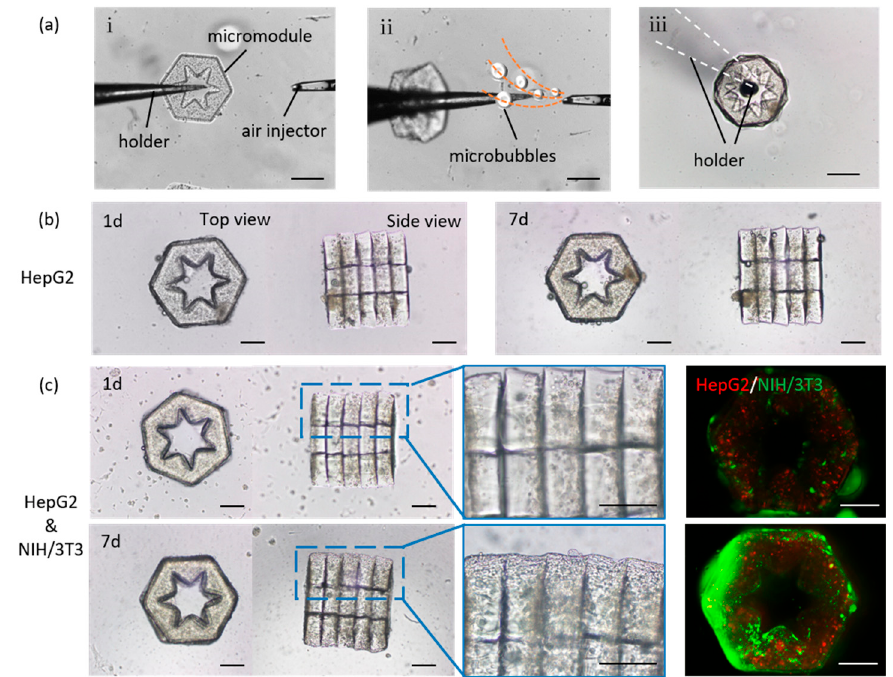
Figure 3. ( a ) 3D assembly process of lobule-like microtissues relying on local fluid-based micromanipulation, scale bars: 400 μ m; ( b ) Long-term culture of 3D lobule-like microtissues encapsulating HepG2 cells, scale bars: 200 μ m; ( c ) Long-term co-culture of 3D lobule-like microtissues encapsulating HepG2 cells and NIH/3T3 cells, scale bars: 200 μ m.